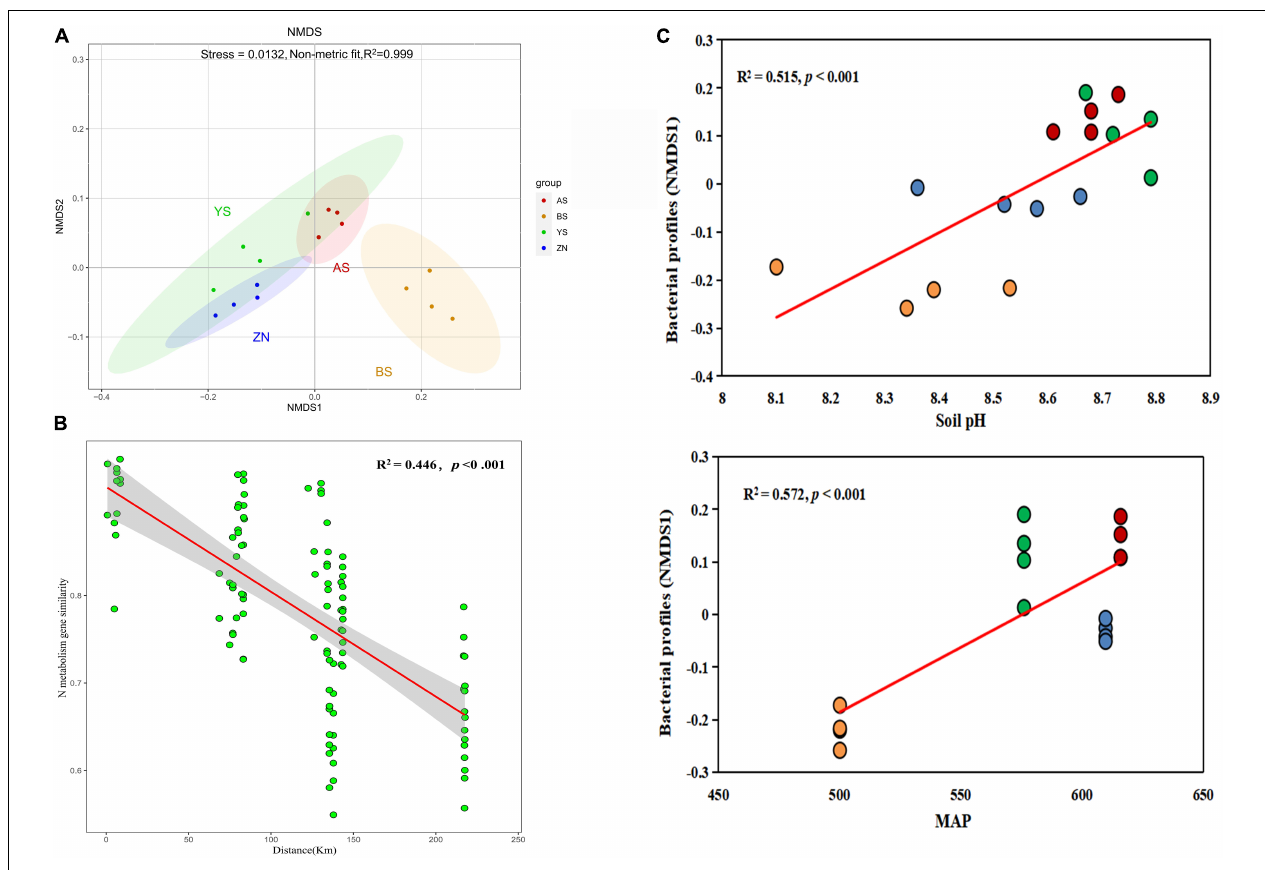
FIGURE 1 | Microbial gene composition for N-metabolism. (A) Non-metric multidimensional scaling plots (NMDS) of microbial gene composition for N-metabolism in the rhizosphere soils of Robinia pseudoacacia in four counties. (B) The distance decay of soil N functional gene similarities based on Bray-Curties distances. (C) DistLM indicates that MAP had the closer correlations with gene composition compared with soil pH.